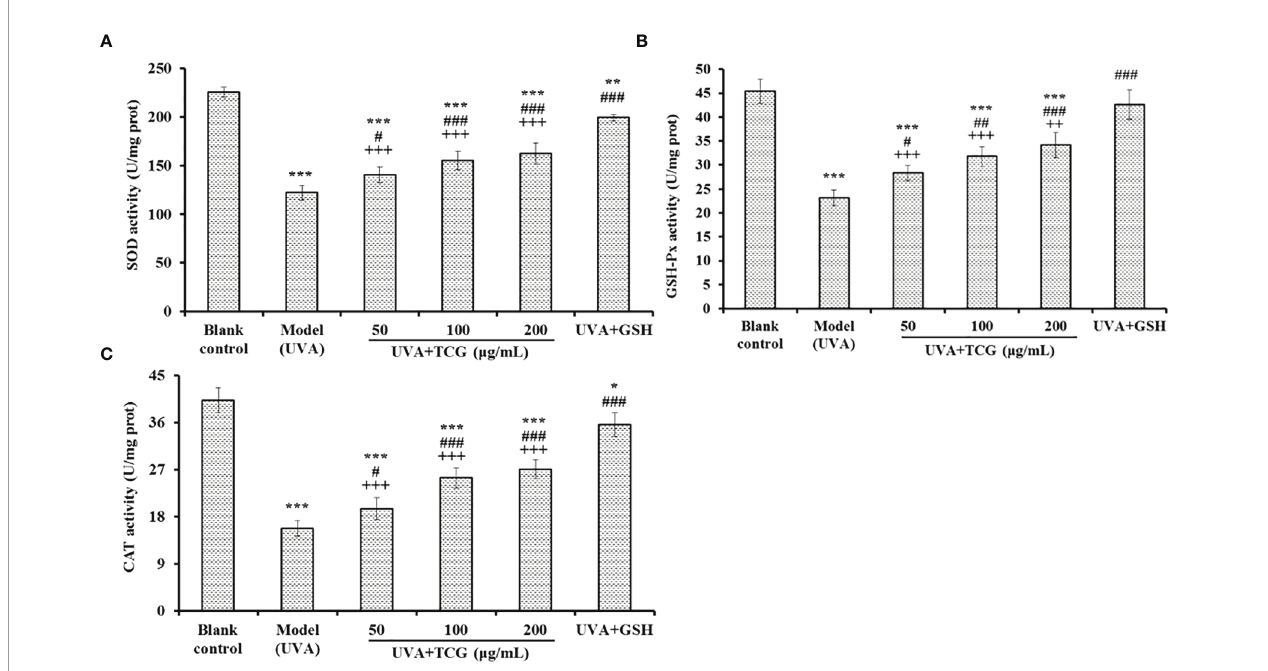
FIGURE 8 | Effects of cartilage gelatin on superoxide dismutase (A) , GSH-Px (B) , and catalase (C) activity in a UVA-injured human skin fi broblasts model. Glutathione (GSH) was used as the positive control. All data are presented as mean ± SD ( n = 3). *** P < 0.001, ** P < 0.01, and * P < 0.05 vs. blank group; ### P < 0.001, ## P < 0.01, and # P < 0.05 vs. model group; +++ P < 0.001 and ++ P < 0.01 vs. UVA + GSH